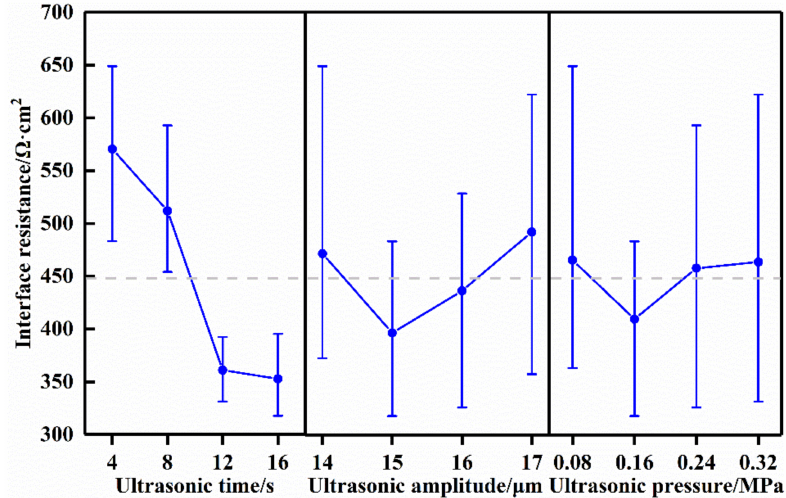
Figure 3. Main effects plot: the effect of each factor on the interface resistance.